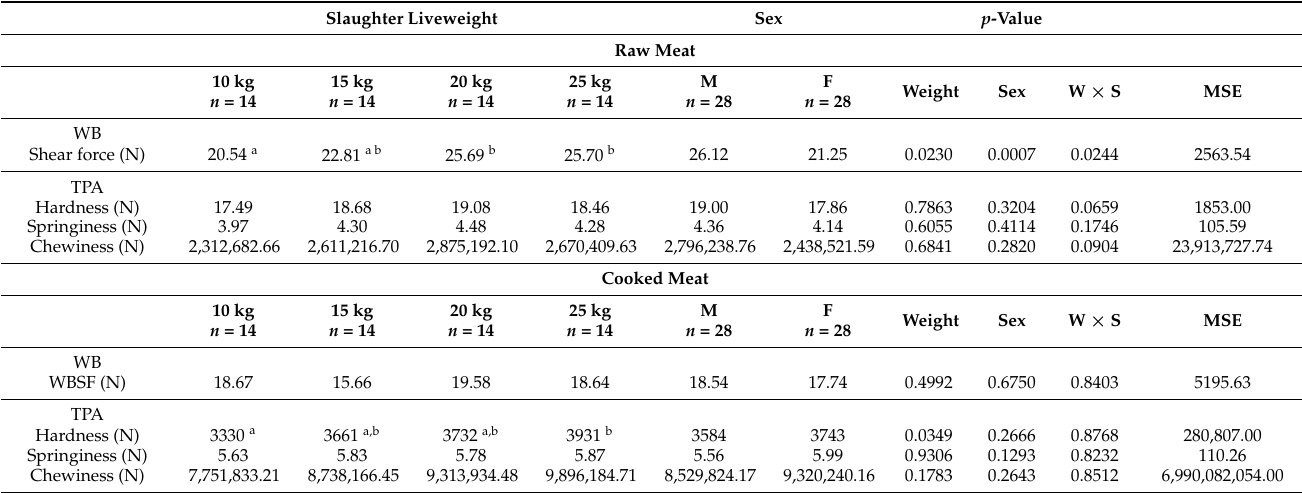
Table 6. Means and mean square errors of the instrumental texture parameters in raw meat and in cooked meat in the four weight groups and in male and female